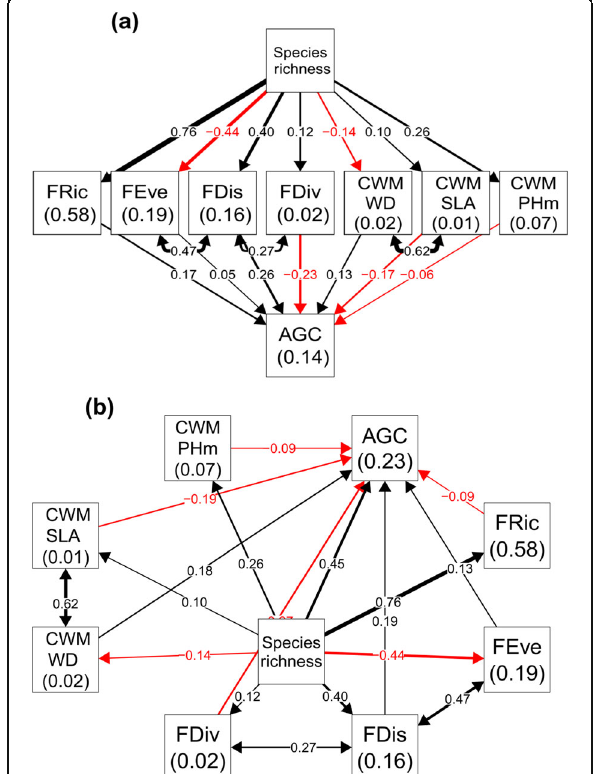
Fig. 3 The best-fit structural equation models (SEMs) for linking species richness, functional diversity, functional dominance, and AGC storage. a Full mediation, b partial mediation. The figures on the lines are the standardized path coefficients. The figures in the box represent the coefficient of determination ( R 2 ). Red arrows denote negative effect paths. Black arrows denote positive effect paths. Double-pointed lines represent the residual correlations. We present the significance of each path and model fit statistics in Table 1. AGC, aboveground biomass carbon; FRic, functional richness; FEve, functional evenness; FDis, functional dispersion; FDiv, functional divergence; CWM, community weight mean; WD, wood density; SLA, specific leaf area; PHm, maximum plant